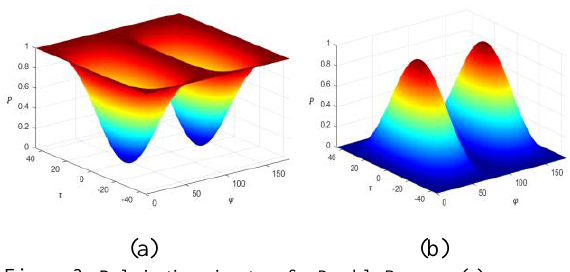
Figure 3. Polarization signature for Double Bounce. (a) co- polarized (b) cross-polarized